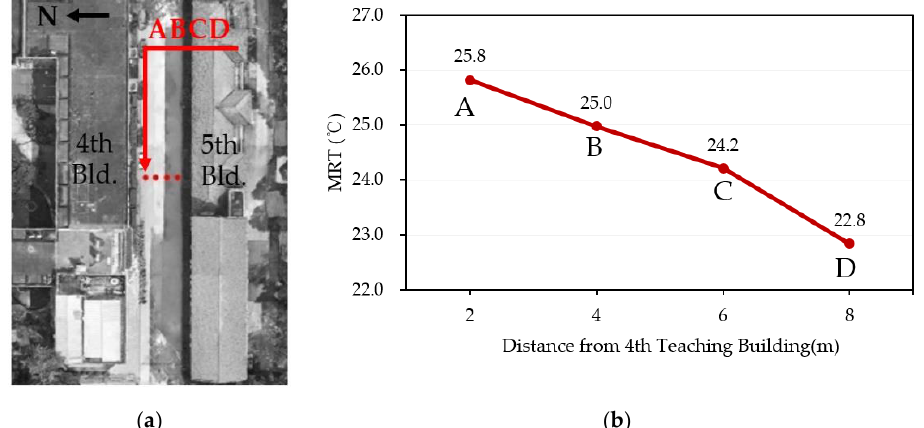
Figure 4. Locations and MRT values at analysis points A–D in the pedestrian space between the teaching buildings. ( a ) Locations of analysis points A–D; ( b ) MRT values at points